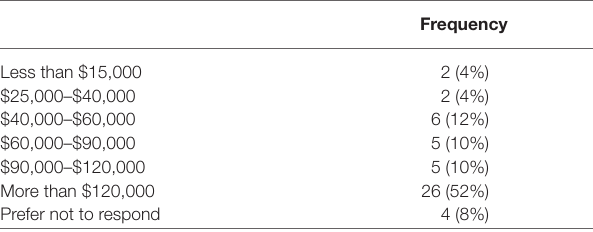
TABLE 3 | Combined household income (Method 1).